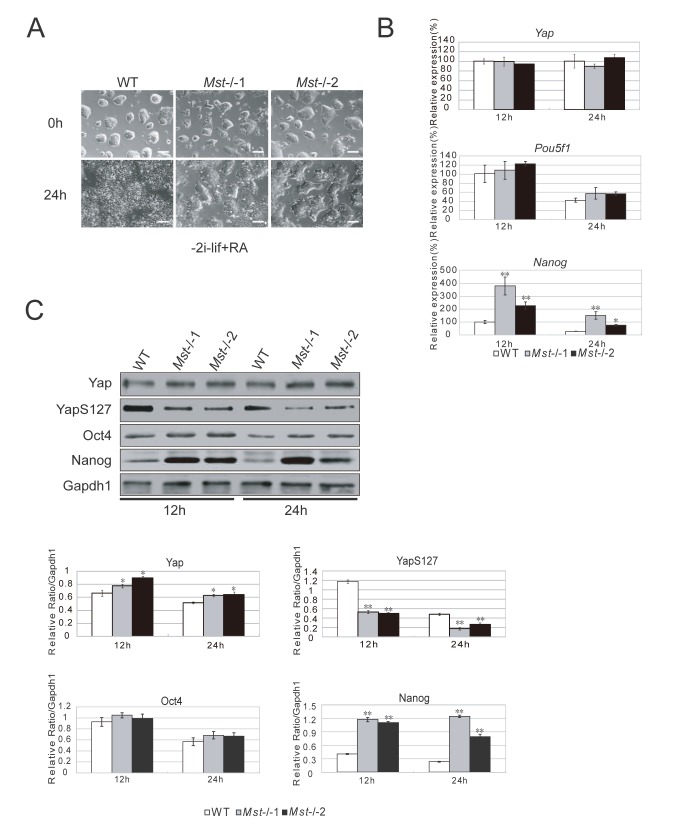
Differentiation resistance of Mst-/- ES cells.(A) Morphology of wild type ES cells and Mst-/- ES cells initially and 24 hour after growing in ES cell differentiation medium supplemented with RA, but not 2i and LIF. Scale bar, 200 μm. (B) Quantitative real-time PCR to examine the mRNA level of Yap, Pou5f1 and Nanog in wild type ES cells and Mst-/- ES cells during ES cell differentiation medium for 12 hours and 24 hours. Actin was analyzed as an internal control. The data are shown as the mean ± S.D (n=3). Statistically significant differences are indicated (*, P<0.05; **, P<0.01; ***, P<0.001). (C) Immunoblotting and densitometric analysis of Yap, YapS127, Oct4 and Nanog in wild type ES cells and Mst-/- ES cells in ES cell differentiation medium for 12 hours and 24 hours. Gapdh1 was analyzed as an internal loading control. The data are shown as the mean ± S.D (n=2). Statistically significant differences are indicated (*, P<0.05; **, P<0.01; ***, P<0.001).